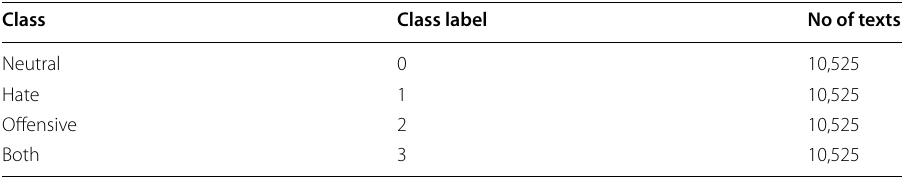
Table 2 Summary of Balanced data distribution in four